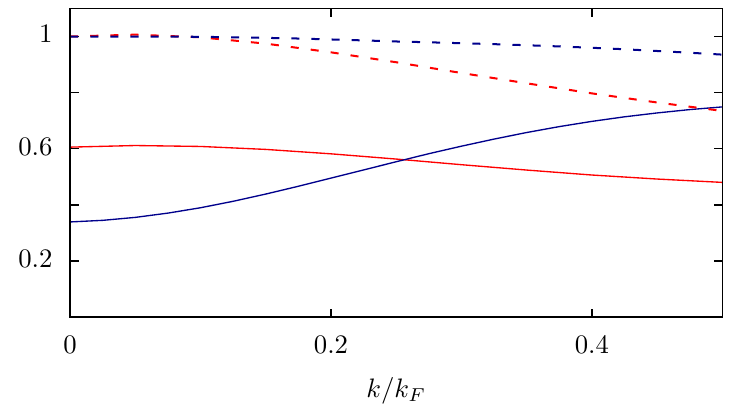
( k ) (solid lines) at thermal equilibrium (with Figure 3: Plot of the static density factor S T temperature T = 1 and density n = 1) at different values of the coupling c , obtained from a numerical evaluation of the one particle-hole contribution (corresponding to the contribution m = 1 in (38)) and the related f-sum rules (39) (dashed lines). At c = 1 (red lines) the f-sum rule decays from the expected value 1 quite fast as k increases, signaling that one particle-hole do not saturate the sum (38) for higher momenta, while at c = 2 (blue lines) the f-sum rule decays much slower as k increases. In both cases the limit k → 0 is exactly given by the one particle-hole contribution as both sum rules converge in this limit to their exact value 1 and the static density factors converge to their exact thermal values given by (8). We conclude that the small momentum part of S ( k , ω ) in (38) is then only given by the one particle-hole contribution m = 1 for any value of the interaction c ≥ 0 up to corrections O (( k / c ) s ) with s >